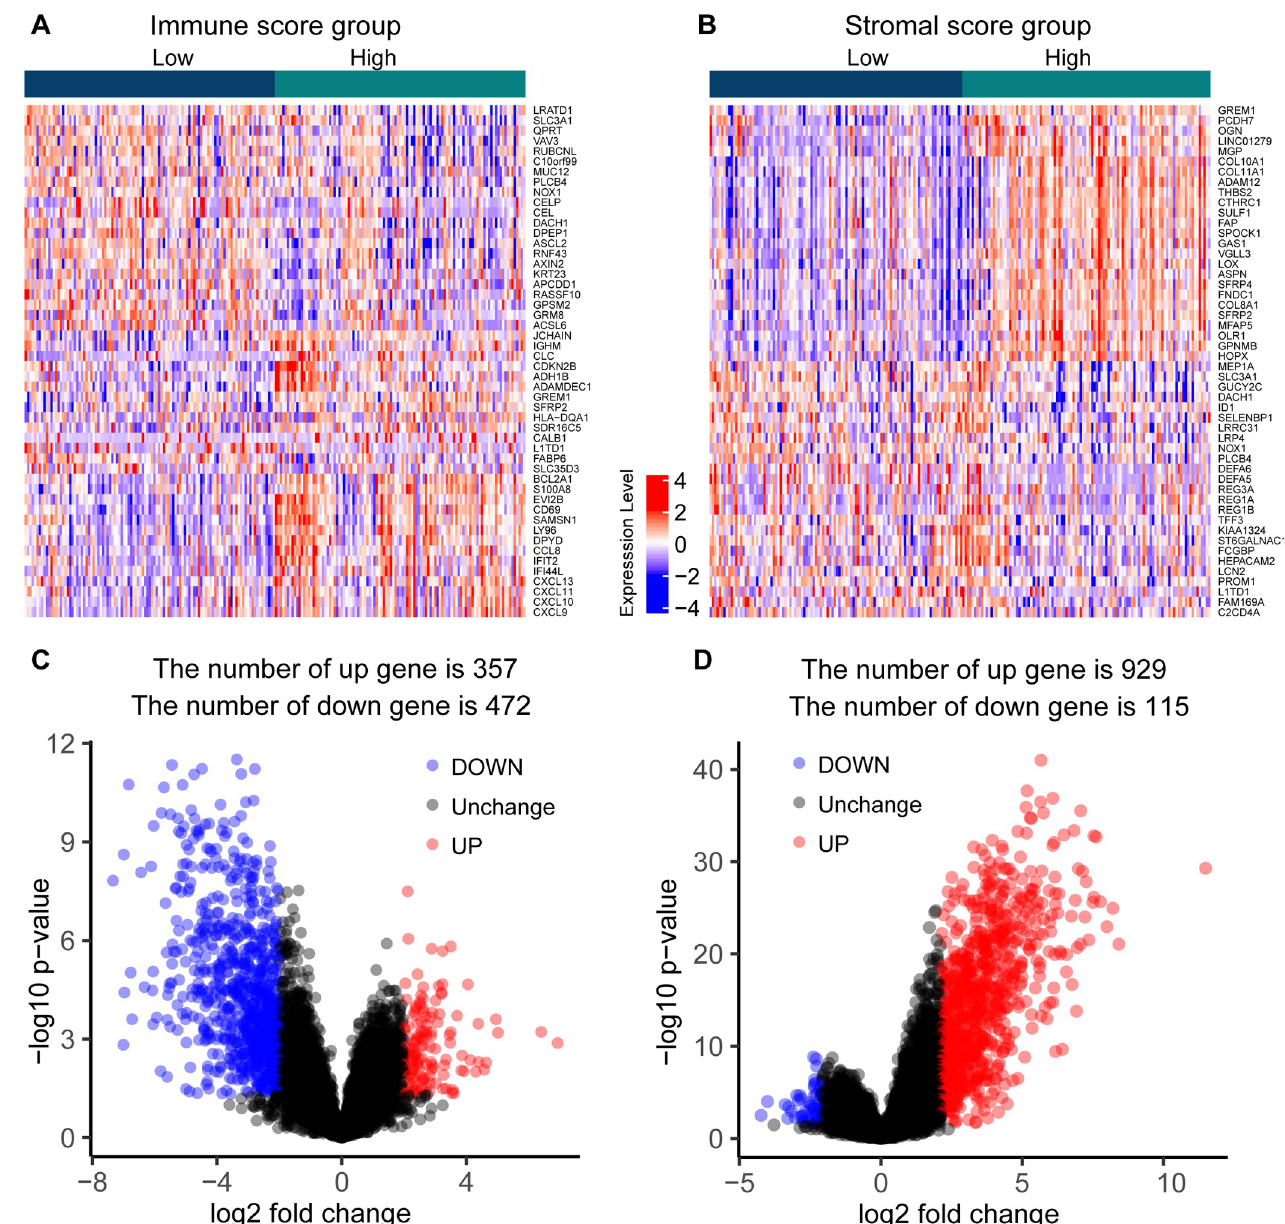
Fig 3. The expression profiles and differential expression analysis results of the top 50 characteristic genes between the high and low stromal and immune score groups. (A) The expression heat map for the top 50 DEGs based on immune score grouping. (B) The expression heatmap for the top 50 DEGs based on stromal score grouping. (C) Volcano maps based on differential expression analysis of immune score groups. (D) Volcano maps based on differential expression analysis of stromal score groups.